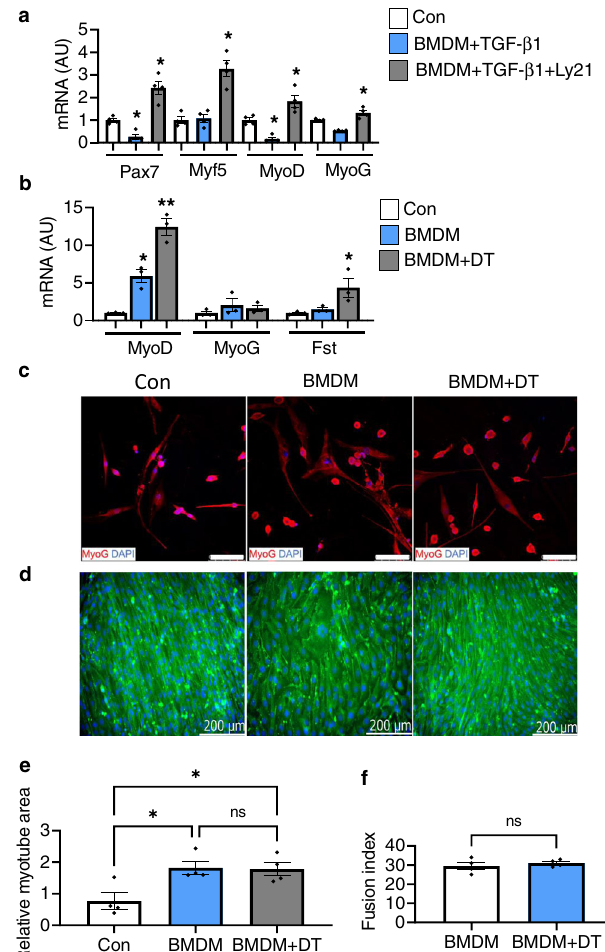
Fig. 5 | Impact ofTGF- β signaling onC2C12 myoblast differentiation. a Relative mRNAexpressionlevelsofmyogenesis-relatedmarkergenesinC2C12myoblastco- cultured with M2-induced BMDM treated with recombinant TGF- β 1 and TGF-